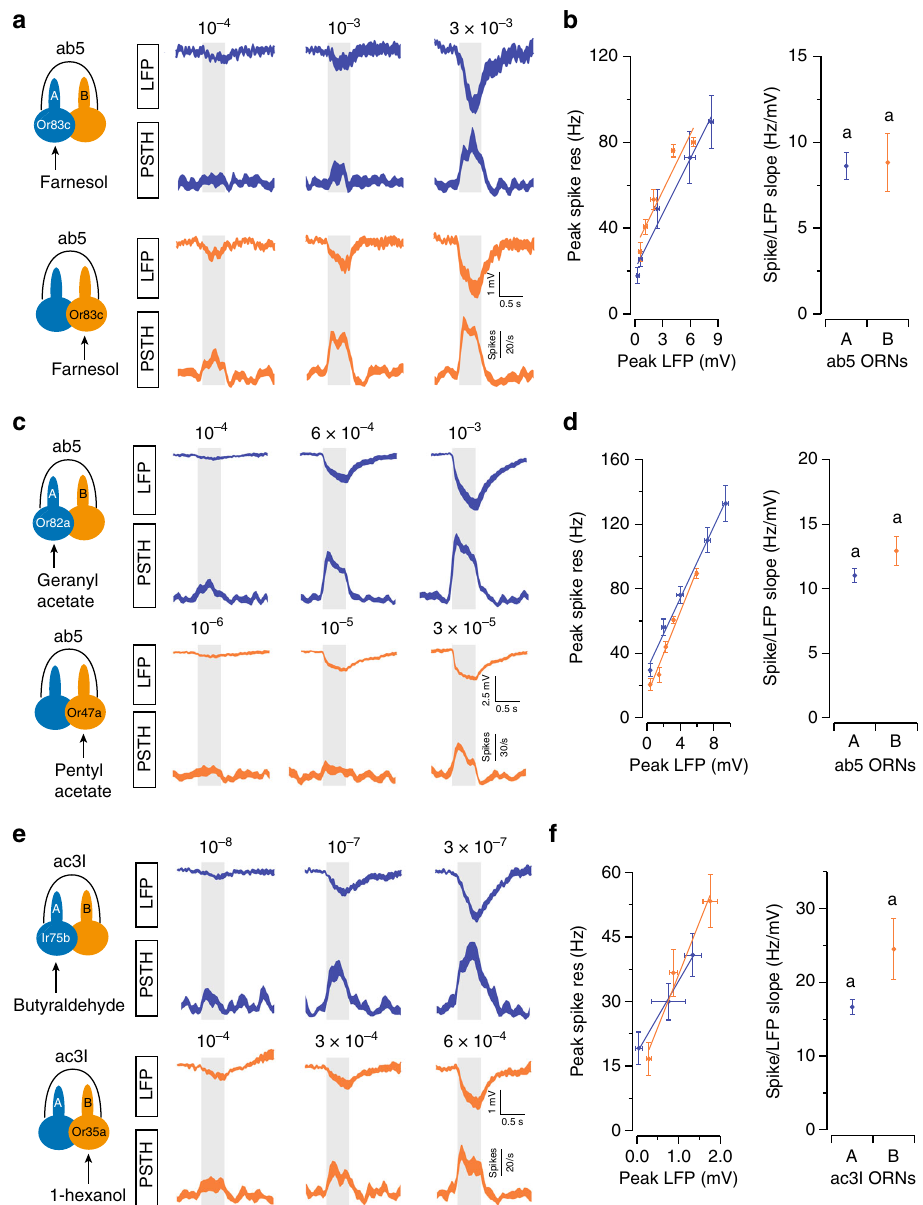
Fig. 4 Spike-LFP analysis in grouped ORNs of similar spike amplitudes. a , b Or83c was ectopically expressed in either ab5A or ab5B using the GAL4-UAS system. ORNs were selectively activated by the odorant, farnesol, at different concentrations. a Average LFP responses and the corresponding spike responses are shown for ab5A (blue traces) and ab5B ORNs (orange traces). b Peak spike responses are plotted as a function of peak LFP responses. Left panel: Lines indicate linear fi ts ( y = ax + b ). n = 9, mean ± s.e.m. Right panel: The respective “ a ” coef fi cients (spike/LFP slope) for ab5A and ab5B are plotted for comparison. Error bars = s.d. c – f Similar to ( a , b ) except that ab5 ORNs ( c , d ) or ac3I ORNs ( e , f ) were selectively activated by their cognate private odorants at different concentrations. n = 9 pairs of ORNs for ( c , d ) and six pairs for ( e , f ), mean ± s.e.m. Statistical analysis was performed with ANCOVA and signi fi cant differences ( P < 0.05) are denoted by different letters. The P values are b 0.08; d 0.165; f 0.227. Source data are provided